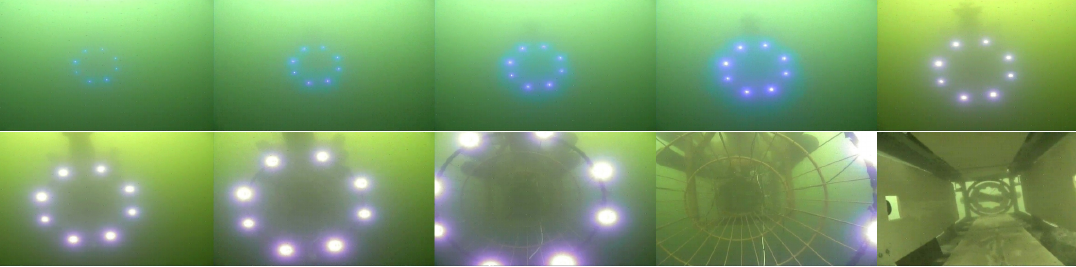
Figure 13. Images of the recycling process of Run 1.